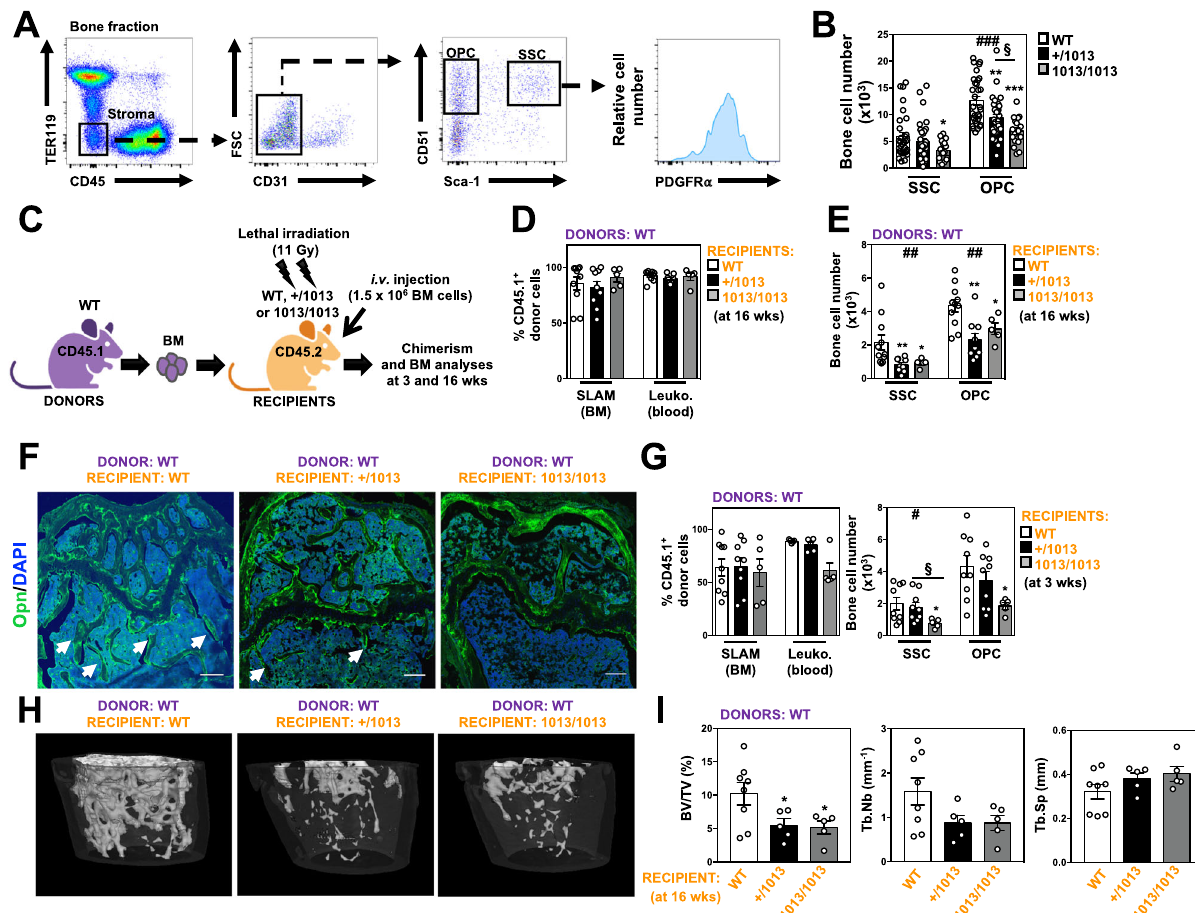
Fig. 2 | Reduction of skeletal stromal cells in Cxcr4 1013 -bearing mice. A Representative dot-plots showing the fl ow cytometric gating strategies used to sort stroma cells (CD45 - TER119 - ), differentiated osteoblast progenitor cells (OPCs, CD45 - TER119 - CD31 - Sca-1 - CD51 + PDGFR α +/- ) and SSCs (CD45 - TER119 - CD31 - Sca- 1 + CD51 + PDGFR α + )inthemousebonefraction. B Absolutenumbersoftheindicated stroma cell subsets from bone fractions were determined by fl ow cytometry. Data (means±SEM)arefromatleastsixindependentexperimentswith n =31,31,and17 mice in total for WT, +/1013, and 1013/1013 groups, respectively. Statistics were calculated with the nonparametric Kruskal – Wallis H test ( ### p <0.0001, OPC) and the unpaired two-tailed Student ’ s t test (1013/1013 vs WT * p =0.0206 for SSC; +/1013 vs WT ** p =0.0031, 1013/1013 vs WT *** p <0.0001, +/1013 vs 1013/1013 § p =0.0217 for OPC). C Schematic diagram for the generation of recipient groups, respectively. Statistics were calculated with the nonparametric Kruskal – Wallis H test ( ## p =0.0064) and the nonparametric Mann – Whitney test, two-sided (+/1013 vs WT ** p =0.0042, 1013/1013 vs WT * p =0.0126, for SSC; +/1013